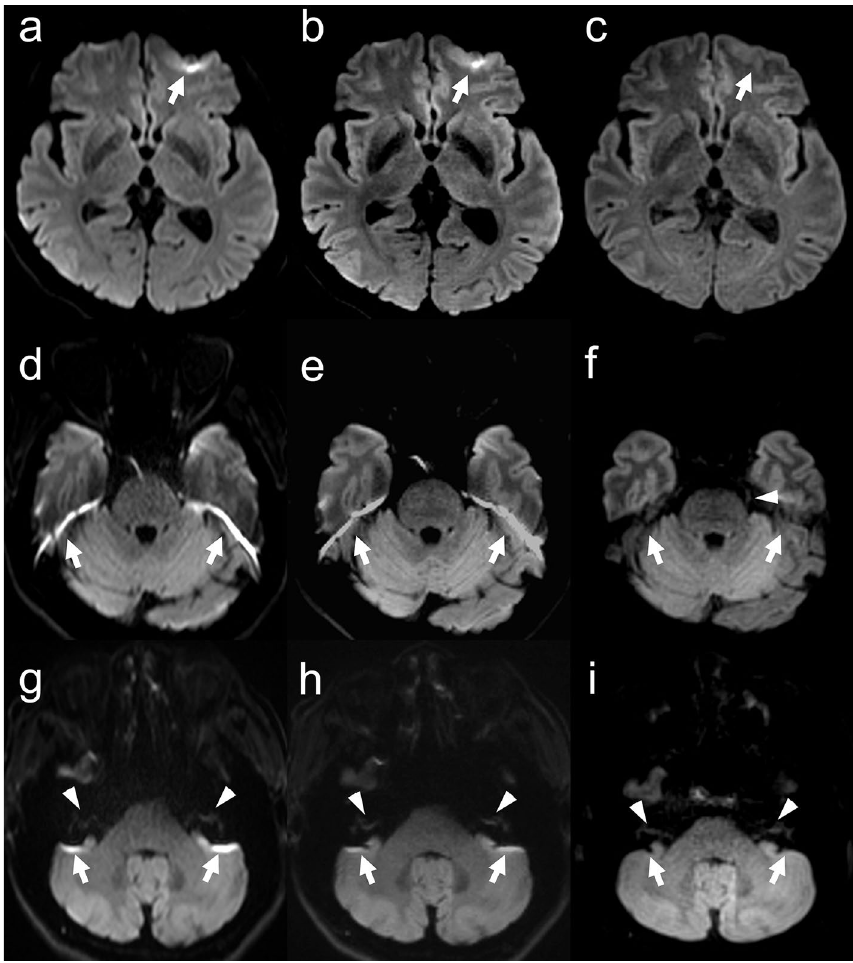
Figure 2. Representative images of SS-EPI DWI ( a , d , g ), RESOLVE DWI ( b , e , h ), and TGSE-BLADE DWI ( c , f , i ) in a 67-year-old healthy female volunteer. The arrows indicate susceptibility artifacts. Artifacts are seen near air–bone interfaces in RESOLVE DWI and SS-EPI DWI, whereas few artifacts are seen in TGSE-BLADE DWI. The trigeminal nerve (arrowhead) in visualized in TGSE-BLADE DWI (f) but is blurred in RESOLVE DWI and SS-EPI DWI. The vestibulocochlear nerve (arrowheads in g–i) are best visualized in TGSE-BLADE DWI.